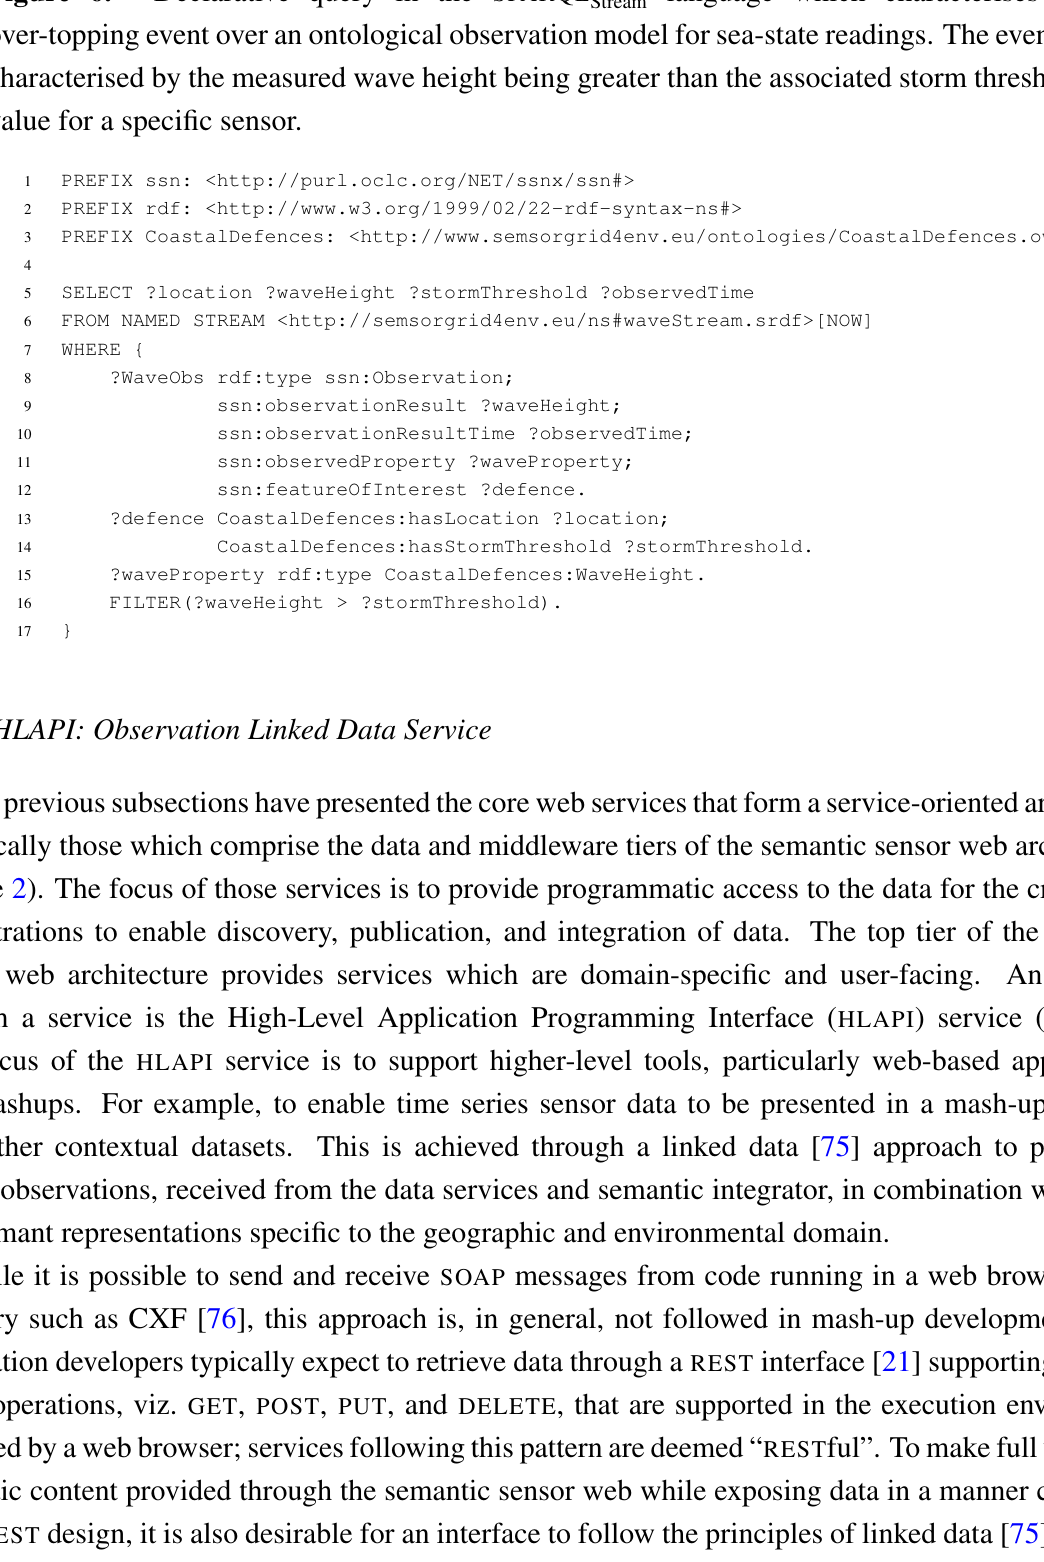
language which characterises an Stream